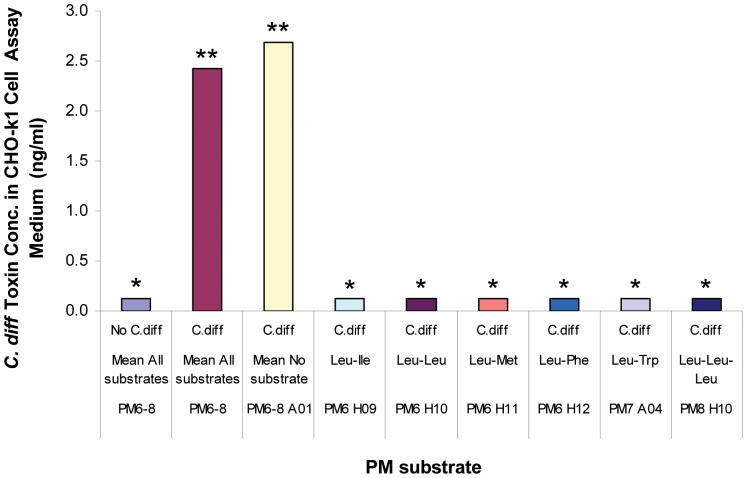
Repression of C. difficile toxin production by leucine dipeptides and the triple leucine tripeptide.* Since the dye reduction rate by CHO-k1 cells under the condition was greater than the upper limit indicated in Table 1, the estimated minimum toxin concentration value (0.12 ng/ml) measurable in this assay was taken for plotting purpose, which was actually <0.12 ng/ml or could even be 0 ng/ml. ** The corresponsing dye reduction rates were within the range covered by the equation in Table 1. Therefore, these toxin concentrations were obtained from the rates by calculation. Because all C. difficile supernatants were diluted when tested in CHO-k1 cell assay medium, the actual toxin concentrations in the supernatants were all 21 fold higher than the displayed values.